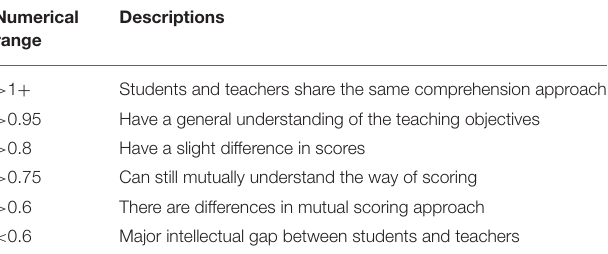
TABLE 5 | Student self-professional growth